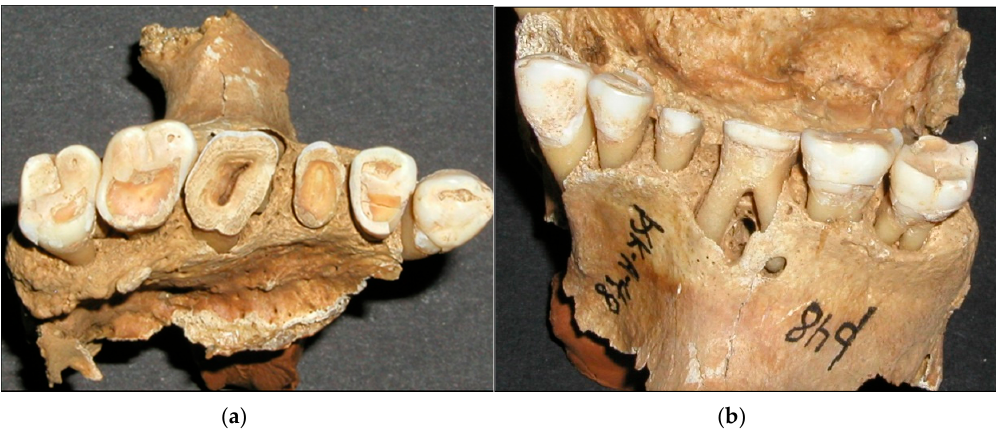
Figure 5. ( a ) Increasing tooth wear according to time of eruption, with pulp exposure in tooth 16. ( b ) Root abscess in tooth 16 due to tooth wear.